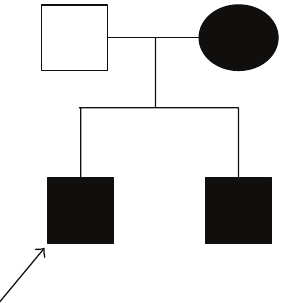
Figure 1: Pedigree chart of the patient’s family showing the inheri- tance of AI in the family studied.